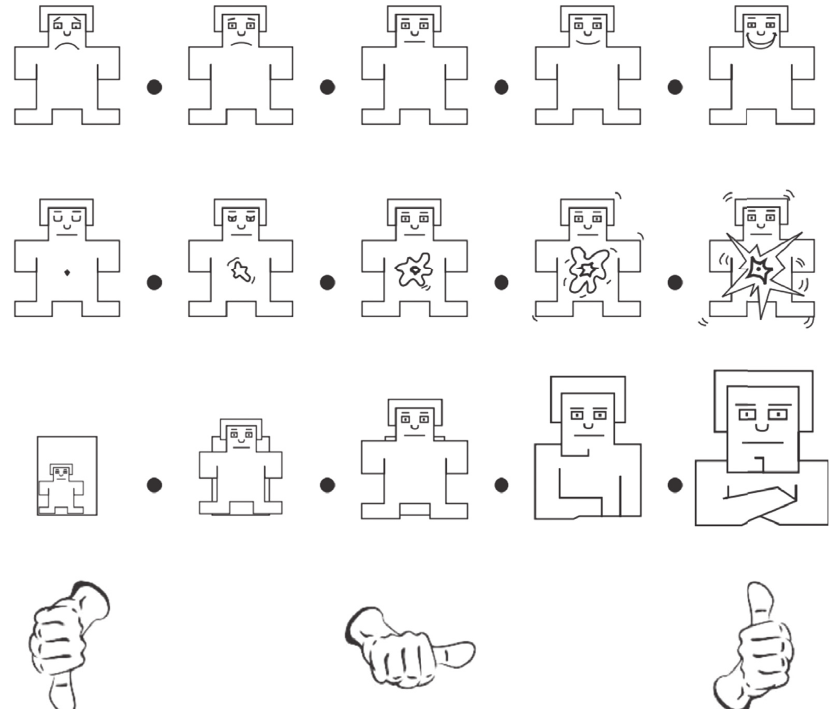
Figure 1: Images used for self-assessment. From the top: Valence SAM, Arousal SAM, Dominance SAM, and Liking.